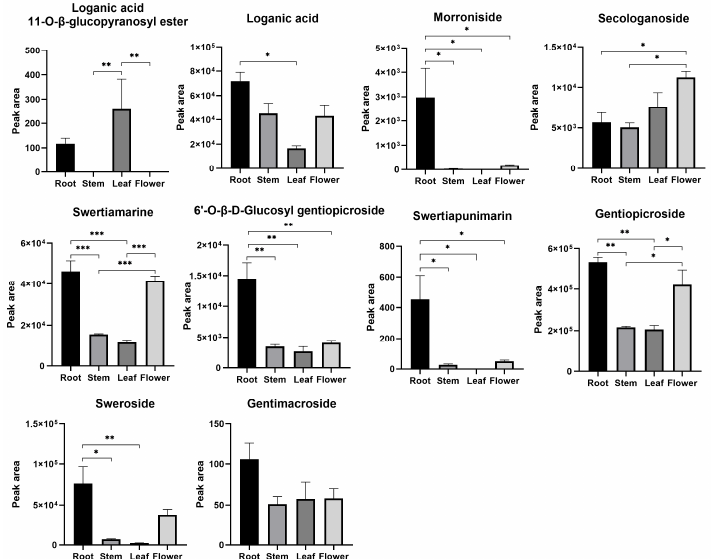
Figure 10. Relative contents of iridoids in different parts of G. macrophylla by the peak area of chromatograms. * p < 0.05, ** p < 0.01, and *** p < 0.001. Data are represented as means ± S.E.M of n = 3 replicates.